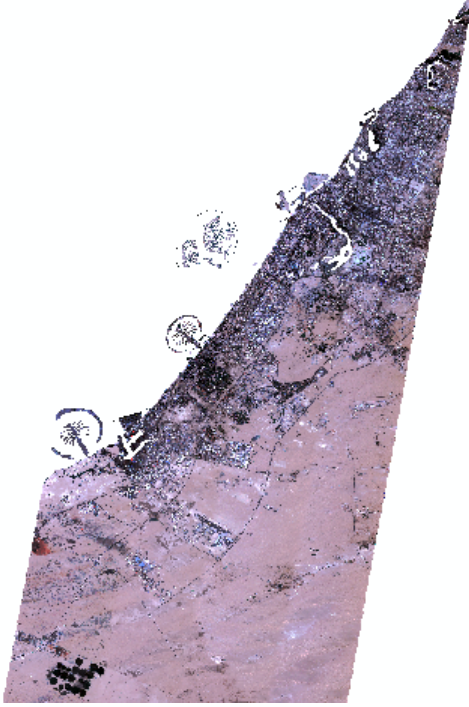
Figure 7. The remapping of DubaiSat-2 mosaic to Surface